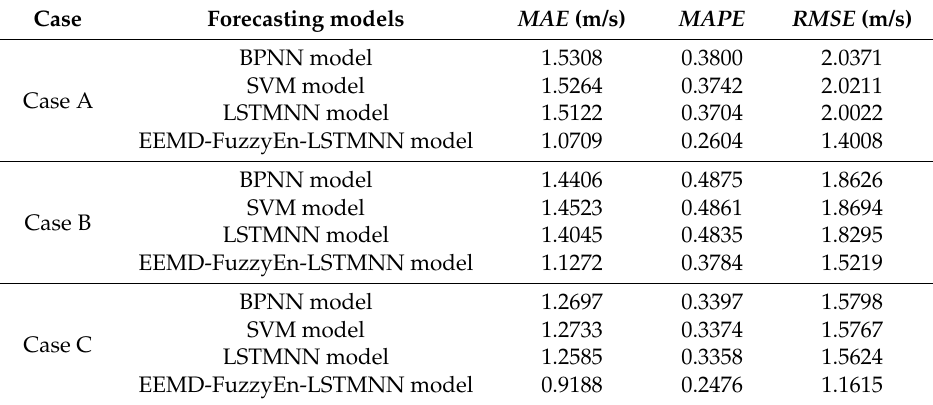
Table 4. Calculation results of error evaluation indexes for the four forecasting